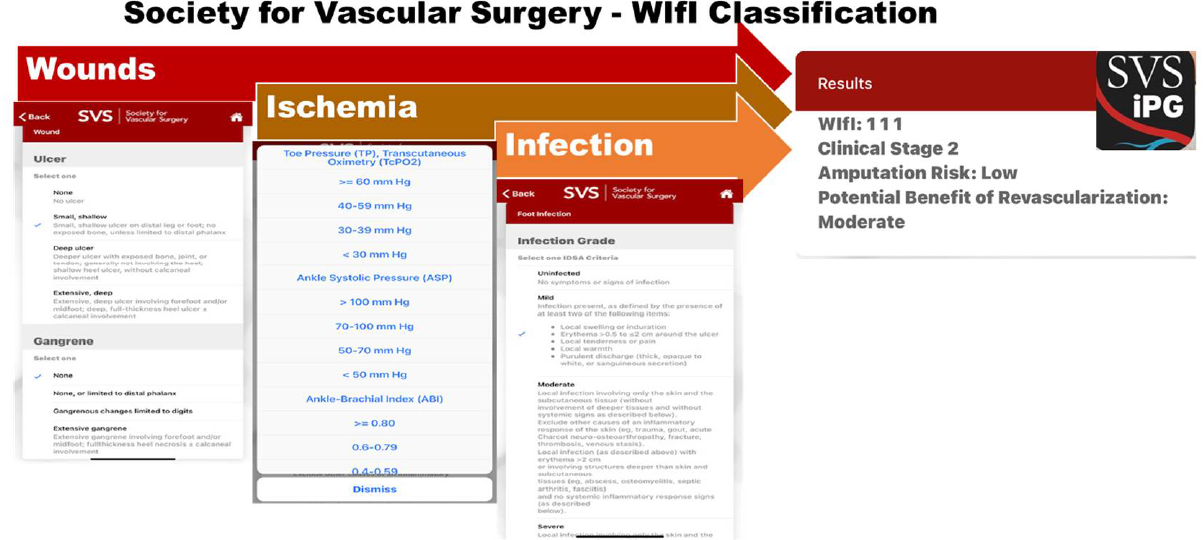
Figure 3. The Society for Vascular Surgery WIfI classification application (SVG iPG). The SVS iPG application provides education on different types of wounds and classifies wound based on three major factors that impact amputation risk. It also includes a comprehensive recommendation to manage each wound type including the need to make a referral for revascularization. The WIfi classification is based on simple and easy to collect info including wounds characteristics (size and presence of gangrene), ischemia (assessed using one of the three vascular metrics: Toe Pressure, Ankle Systolic Pressure, or Ankle Brachial Index), and degree of